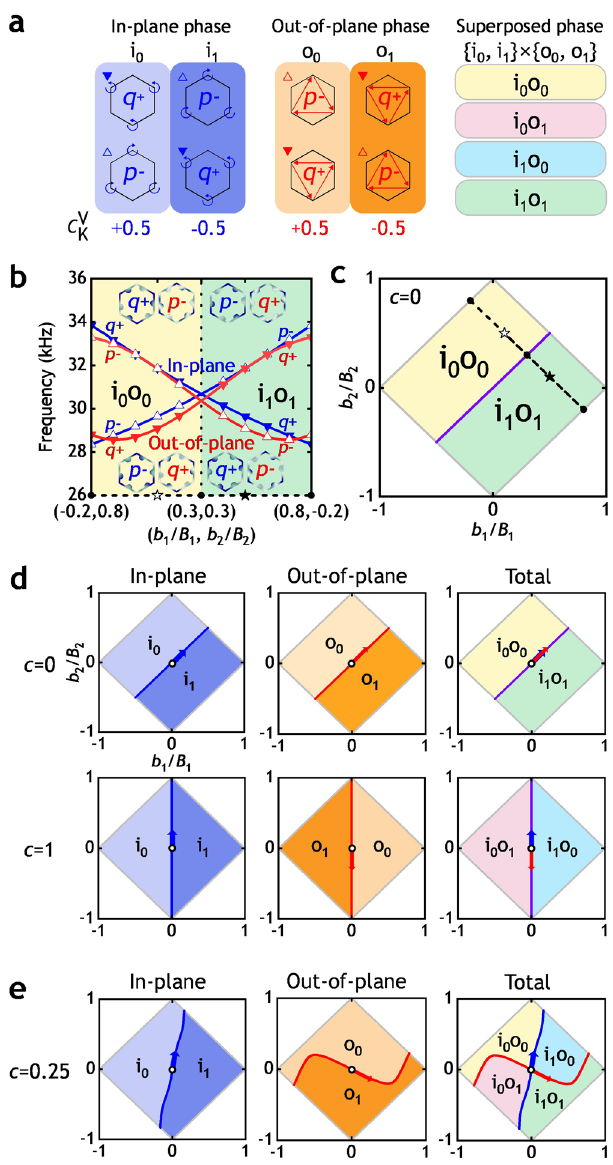
Fig. 3 Superposed valley Hall phase and phase diagram. a In-plane polarized (IPP), out-of-plane polarized (OPP), and superposed valley Hall phase of the phononic crystal (PC). Frequency order between p − and q + states and ideal valley Chern numbers at valley K linked to each IPP or OPP phase are denoted. Different colors assigned to each valley Hall phases are shown, for example, yellow for the phase i 0 o 0 . b Superposed phase diagram of PCs with c = 0 and restricted perturbation b 1 / B 1 + b 2 / B 2 = 0.6. Blue and red solid lines represent the IPP and OPP band-edge frequencies at point K, and symbols on the lines represent the Bloch states. Insets show the energy distributions of the Bloch states at ( b 1 / B 1 , b 2 / B 2 ) = (0.1, 0.5) (empty star) and ( b 1 / B 1 , b 2 / B 2 ) = (0.5, 0.1) ( fi lled star). c Superposed phase diagram of PCs with c = 0. A solid violet line indicates the deterministic Dirac degeneracy or phase transition line. The Black dashed line indicates the restricted perturbations used in ( b ). d IPP, OPP, and superposed phase diagram of PCs with c = 0 and 1. Blue (red) lines and arrows in IPP (OPP) phase diagram represents the phase transition line and direction of the phase transition line at origin ( b 1 / B 1 , b 2 / B 2 ) = (0, 0), respectively. A superposed phase diagram is nothing but the superposition of IPP and OPP phase diagram; the violet line is a superposition of blue and red lines. e IPP, OPP, and superposed phase diagram of PCs with c = 0.25. All superposed phases appear, different from the diagram of ( d ) c = 0 and